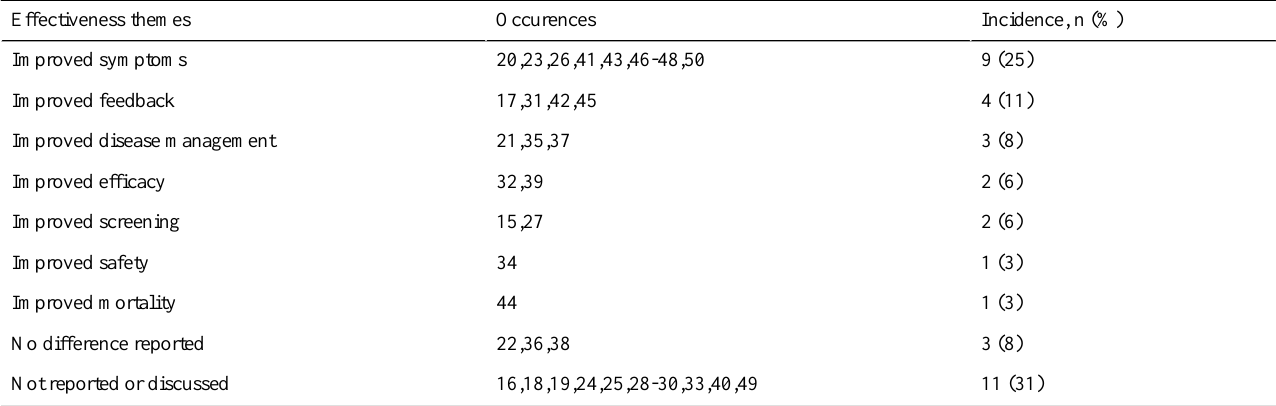
Table 3. Summary of themes identified for patient medical outcomes